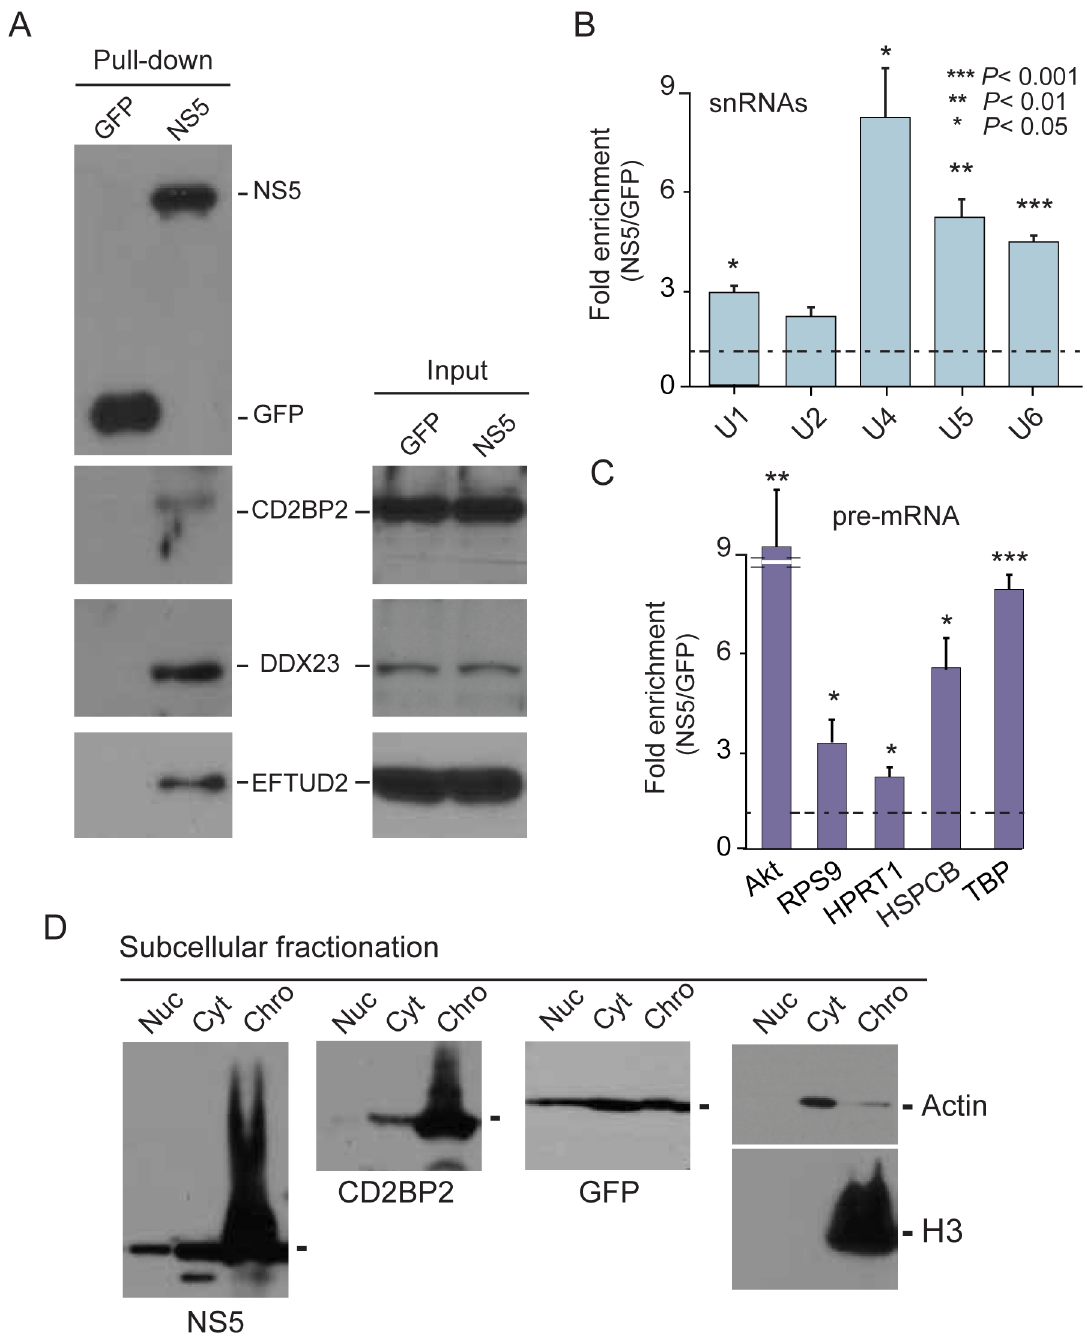
Fig 2. NS5 interacts with splicing proteins in the context of active spliceosomes. (A) NS5 binds CD2BP2, DDX23, and EFTUD2. Pull down assays and western blot analysis of indicated proteins are shown. (B) NS5 binds to assembled snRNPs containing the U1, U2, U4, U5, and U6 snRNAs. (C) Detection of indicated pre-mRNAs in the NS5 associated complexes. (D) Subcellular fractionation showing that NS5 accumulates in the insoluble chromatin fraction, similar to CD2BP2, a U5 snRNP component (Nuc: nucleoplasm, Cyt: cytoplasm, Chro: chromatin). Fractionation of cells expressing GFP is also shown as control, indicating that this protein distributes along different cellular compartments.